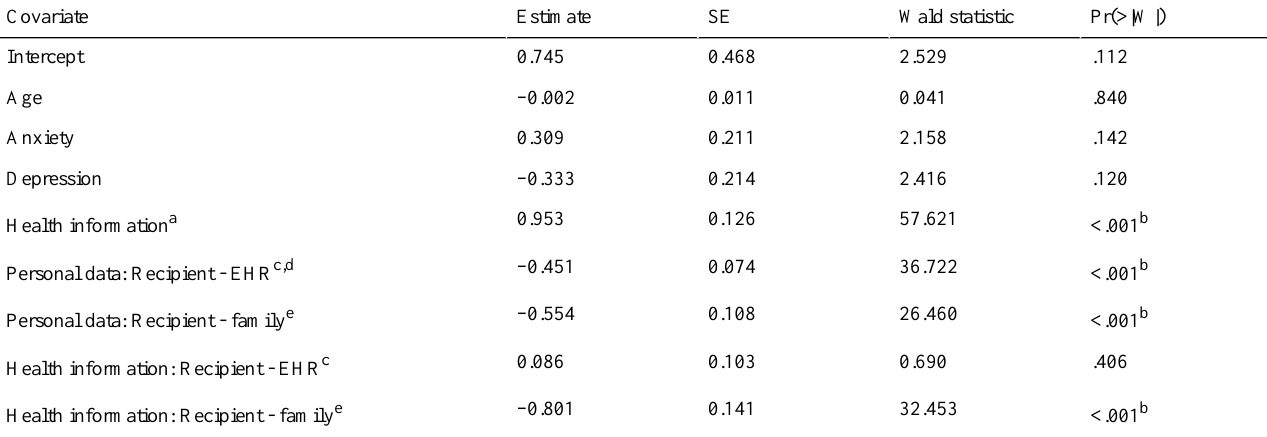
Table 3. Model summary of participants’ comfort with sharing “health information” (sleep, mood, and physical activity) and “personal data” (communication logs, location data, and social activity) with their doctor, the electronic health record system, or family members.